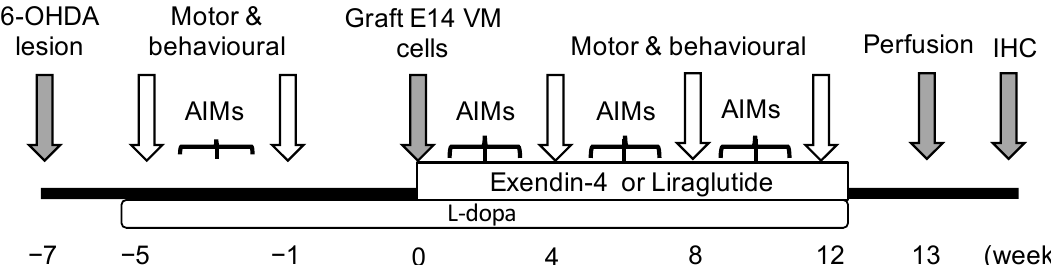
Figure 1. Schematic illustration for experiment time line: 6-OHDA lesion induced at week 7 before cell transplantation; L-dopa treatment started at week 5 before cell transplantation and continued for 12 weeks post transplantation. GLP-1R agonist therapy started immediately after cell transplantation and continued for 12 weeks. Motor tests and AIMs were recorded at intervals prior to, and following cell transplantation. All rats were perfused 13 weeks post-transplantation. AIMs = abnormal involuntary movements.